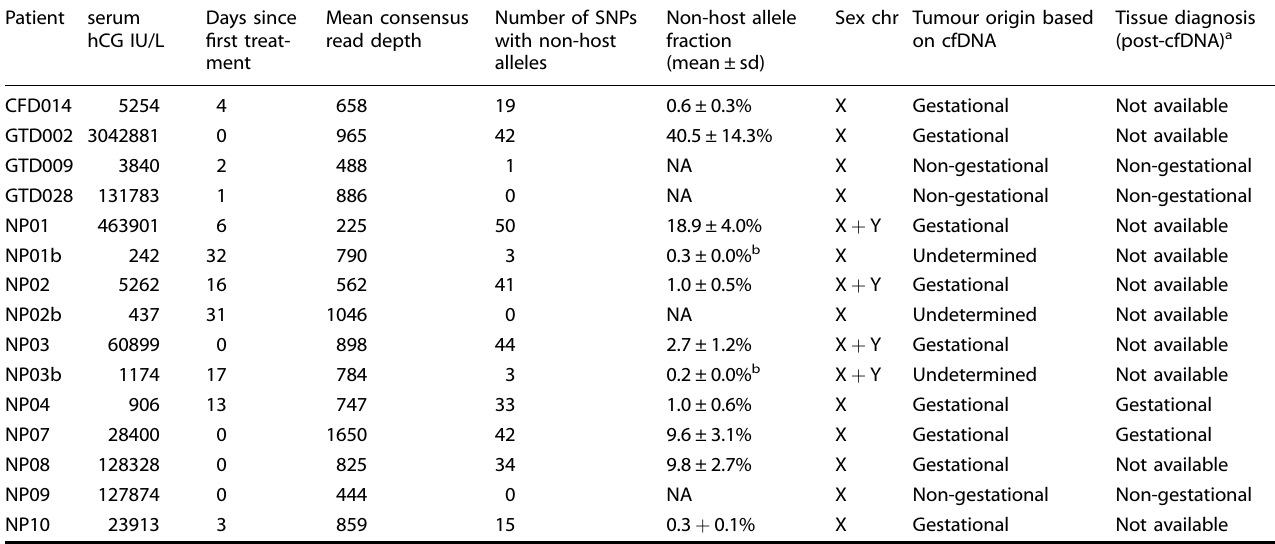
Table 2. Detection of non-host cfDNA in plasma of patients with hCG-secreting tumours of unknown origin. Patient serum hCG